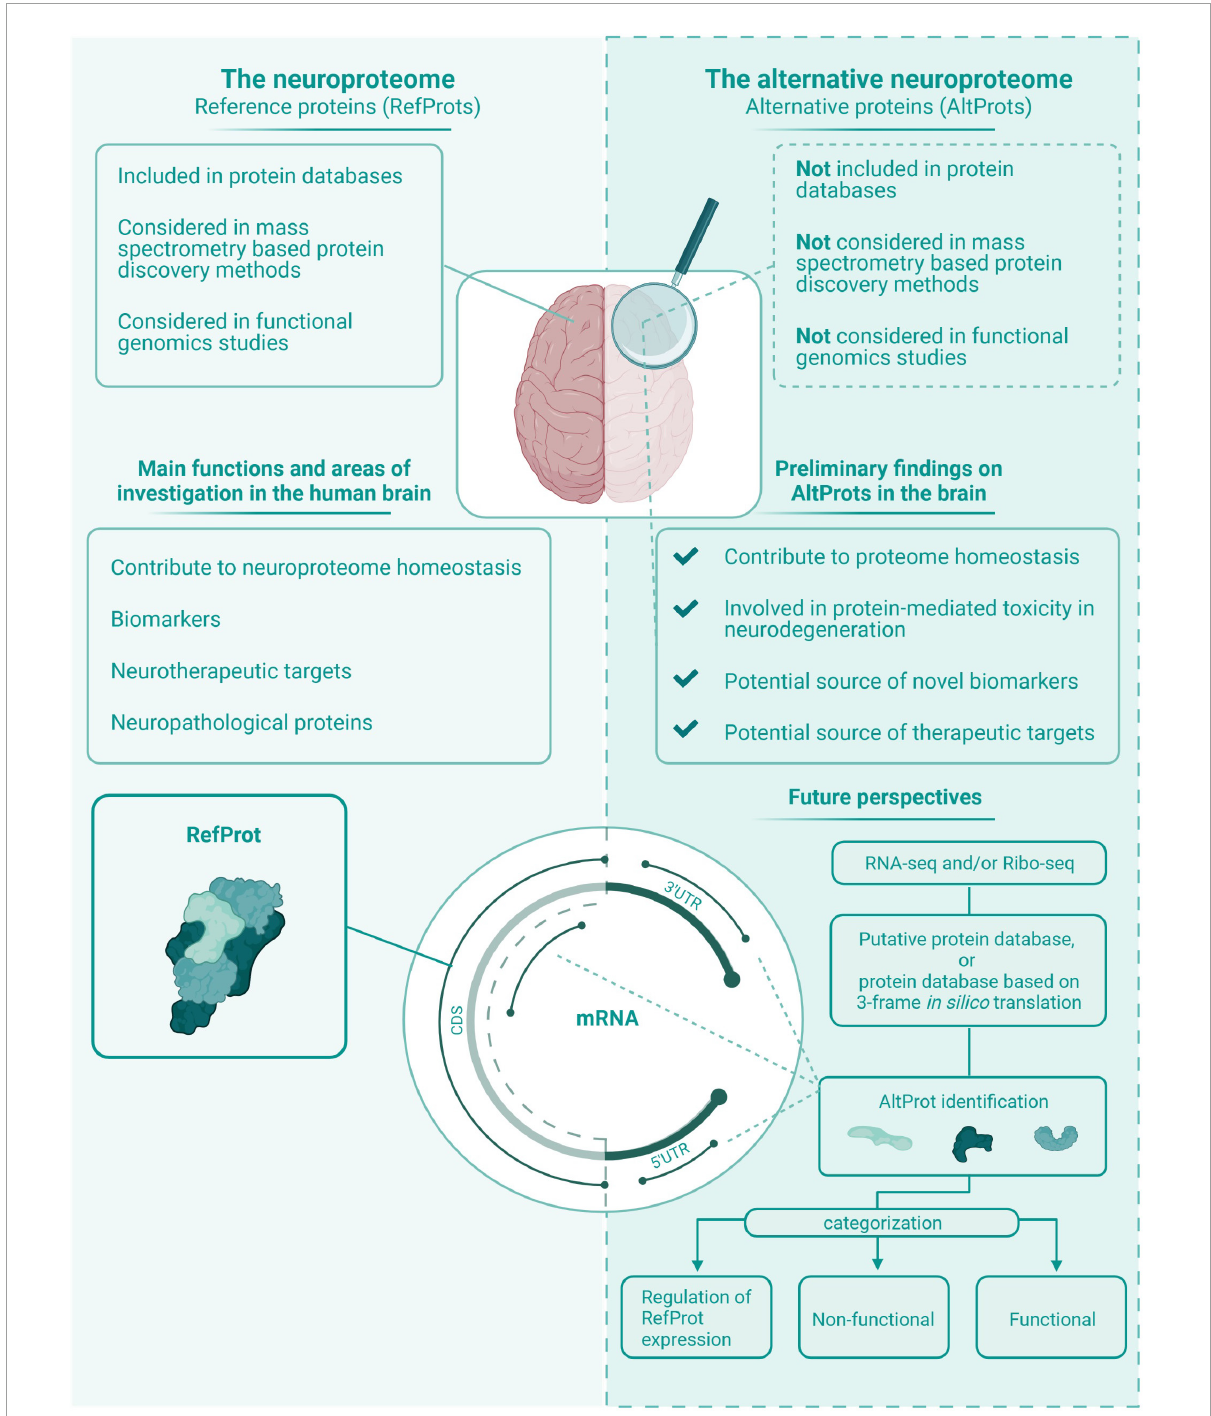
FIGURE5 The neuroproteome vs. the alternative neuroproteome. This value proposition of the alternative neuroproteome highlights the key findings in this exploratory review article. The alternative neuroproteome is an undiscovered area that can increase our understanding of the intricate neuroproteome and is a novel source of potential biomarkers and therapeutic targets. However, subsequent studies have to determine which alternative open reading frame (ORFs) are protein coding, and if the translated alternative protein (AltProt) is either functional, non-functional, and/or involved in the regulation of reference protein (RefProt)